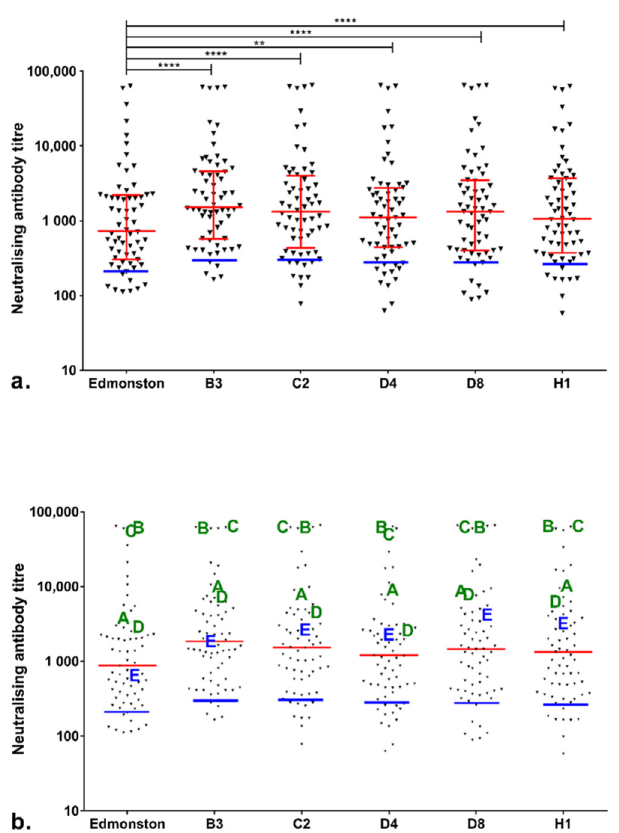
Figure 1. ( a ) Cross-neutralising antibody titres against MeV genotypes in 64 Sheffield HCWs who had their measles immune status checked at the time of the outbreak. Median titres with interquartile ranges are shown in red and Wilcoxon matched-pairs signed-rank test was used for statistical analysis. The blue line in each column indicates the titres of the 3rd WHO measles antibody international standard serum (NIBSC 97/648) diluted to 120 mIU/mL, defined as the protective threshold. Aster- isks indicate statistical significance (**** p < 0.0001; ** p < 0.01). ( b ) Neutralising antibody titres of 64 HCWs and 5 patients displaying measles symptoms. Patients A–D had been vaccinated with two doses of MMR vaccine, whereas patient E had received only one dose.